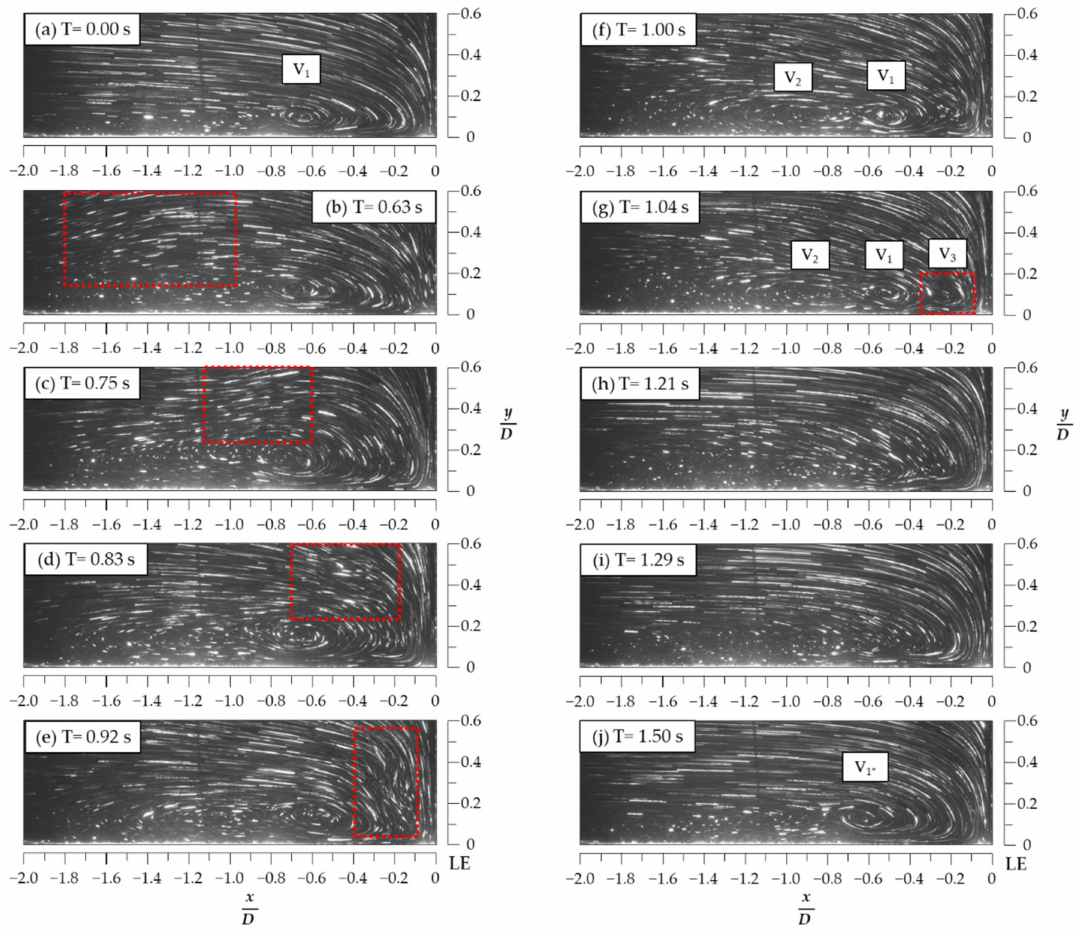
Figure 14. Time-series flow visualization of the HSV’s kinematic mode: “mixed” in the z = 0 cm plane when H / D = 1.5. ( a ) The core of the primary vortex V 1 was initially located at ( x / D , y / D ) = ( − 0.65, 0.10); from ( b ) to ( e ), an unexpected bulk of “flow disturbances“ (red dotted box) was moving into V 1 ‘s region and distorting the flow structure near the vortex V 1 ; ( f ) a new roll-up vortex V 2 was formed upstream V 1 ; ( g ) a new roll-up vortex V 3 was formed downstream V 1 ; from ( h ) to ( j ), all of the primary vortices (V 1 , V 2 , and V 3 ) were “merging” with one another to finally form a new primary vortex V 1* with its core located at ( x / D , y / D ) = ( − 0.62,